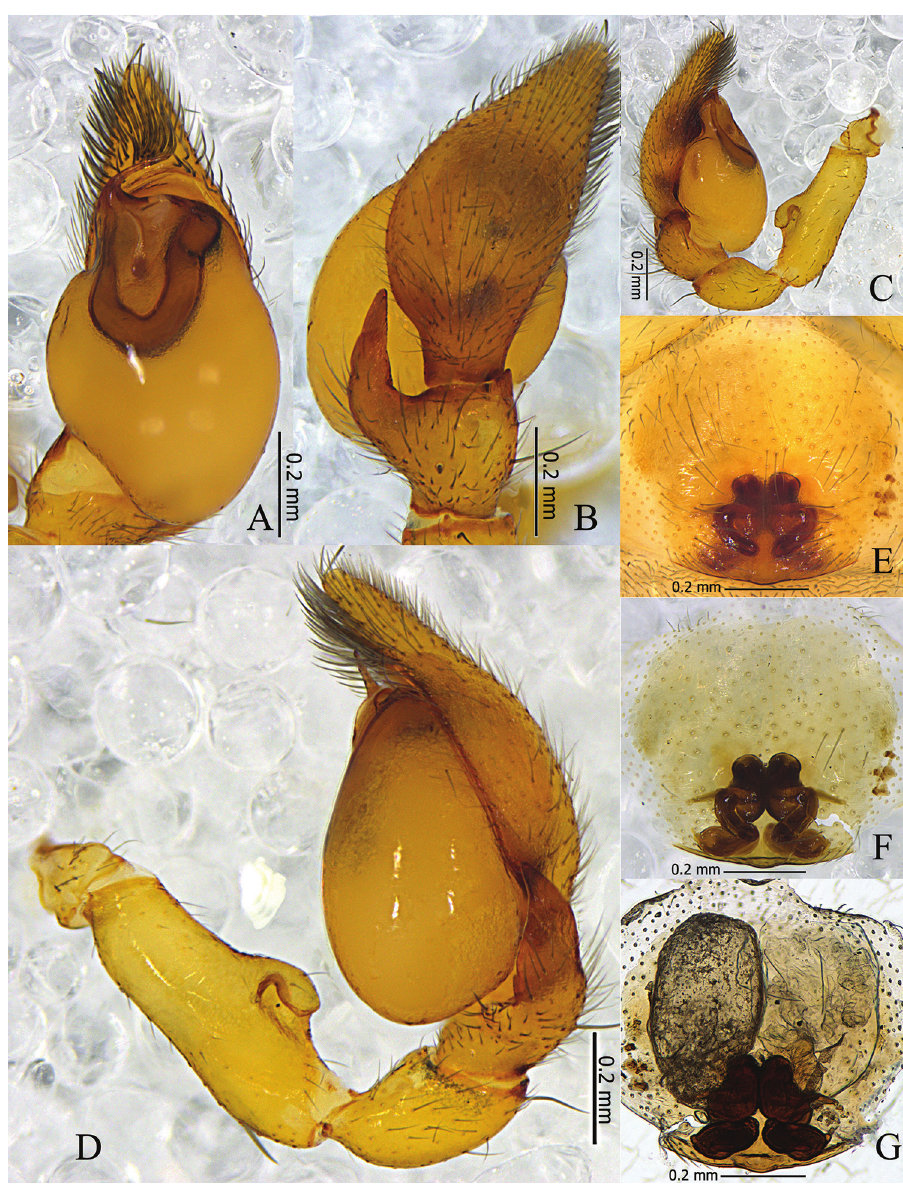
Figure 11. Otacilia submicrostoma sp. n. A left male palp, ventral view B same, dorsal view C same, prolateral view D same, retrolateral view E epigyne, ventral view F same, cleared by potassium hydroxide, ventral view G vulva, dorsal